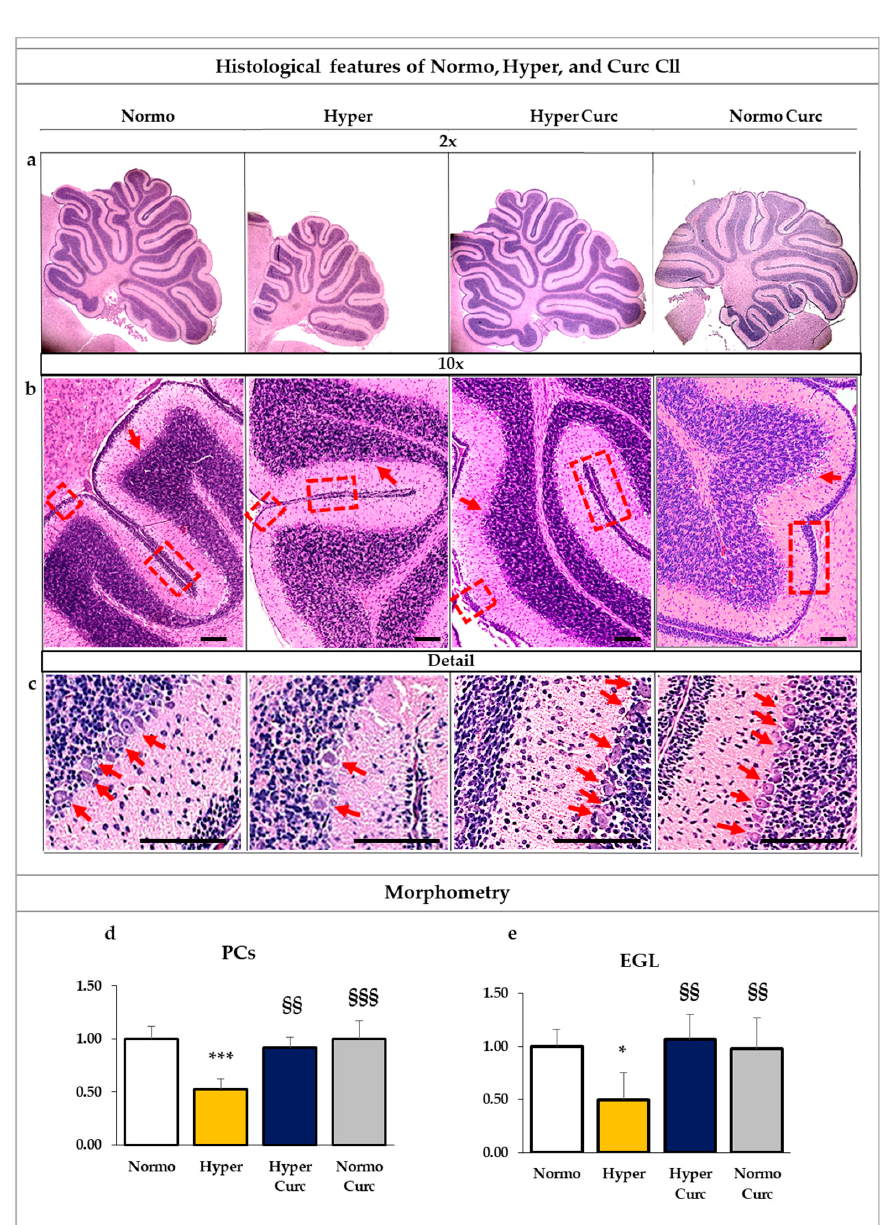
Figure 2. Curc prevents the alterations of the histological and morphometric features characteristic of the Hyper Gunn rat. ( a – c ) Histological features of the cerebellum (Cll) in Normo (normobilirubine- mic), Hyper (hyperbilirubinemic), and curcumin (Hyper Curc and Normo Curc) treated P17 Gunn rats. Different magnifications are shown to allow appreciating the whole Cll details. ( a ) = 2 × : Curc fully prevents the reduction in the volume of the Cll present in the Hyper P17 pups. ( b ) = 10 × : allows to better appreciate the general appearance of the external granule cell layer (EGL, e.g., squares) and the Purkinje cells (PCs, e.g., arrows), both reduced in Hyper, and reverted to the physiological features by Curc. The protective effect of Curc on PC number is even more visible in ( c ) the detailed picture (e.g., arrows). Scale bar: 200 µ m. ( d , e ) Morphometric evaluation of the PC number ( d ) and external EGL thickness ( e ). White bars: Normo; yellow bars: Hyper; blue bars: Hyper Curc; grey bar Normo Curc. Data are in mean ± S.D. and expressed as fold vs. the Normo pups used as reference (=1). Three animals of each genotype and treatment were devoted to this goal. Statistical significance was evaluated by the one-way analysis of variance (ANOVA), followed by a Tukey–Kramer Multiple Comparisons Test when p -value < 0.05. Statistical significance: */***: p < 0.05, p < 0.001 vs. Normo age-matched pups. §§/§§§: p < 0.01, p < 0.01 vs. Hyper age-matched